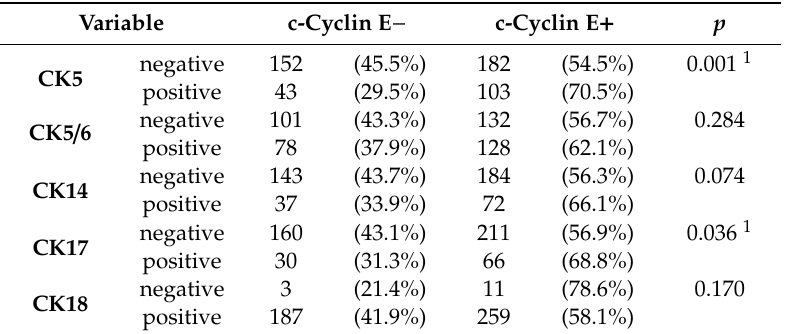
Table 4. Association between tumor c-cyclin E status and clinicopathological